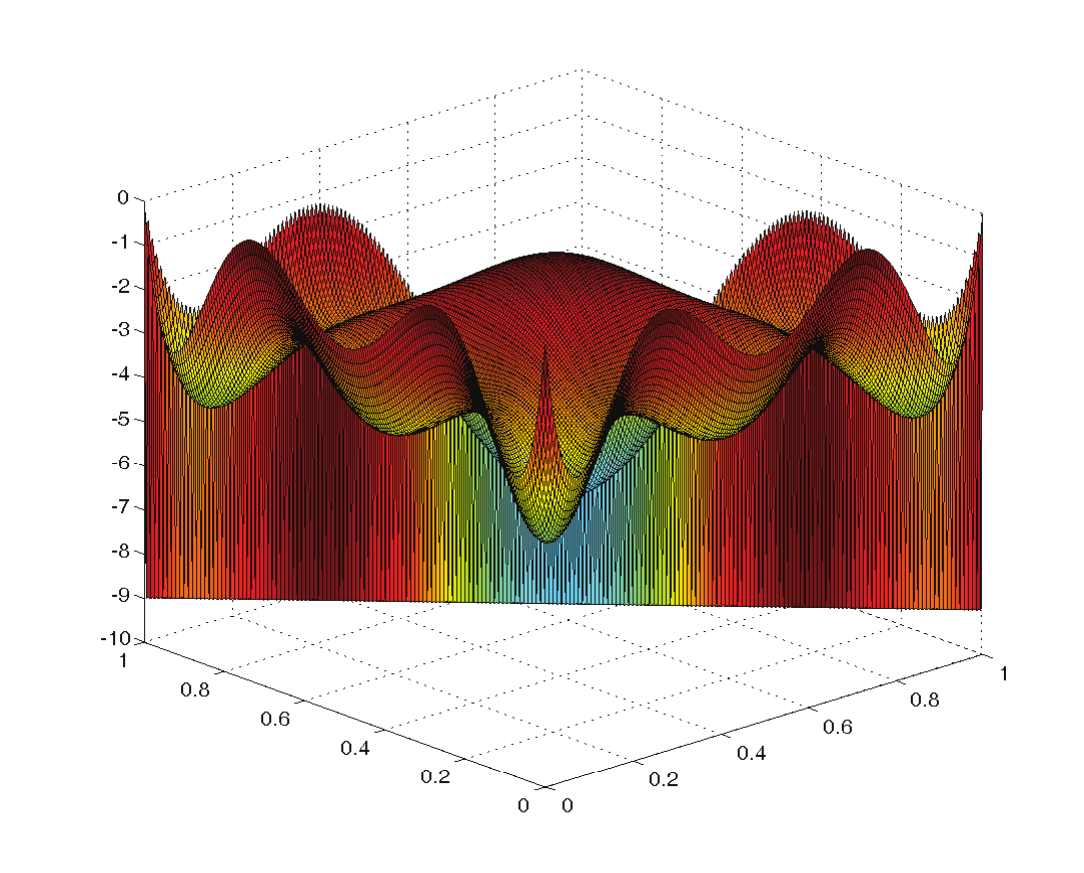
Fig 2. The plot of the directional derivative of the ProjPSO-generated design confirms it is D -optimal design for the IC Model